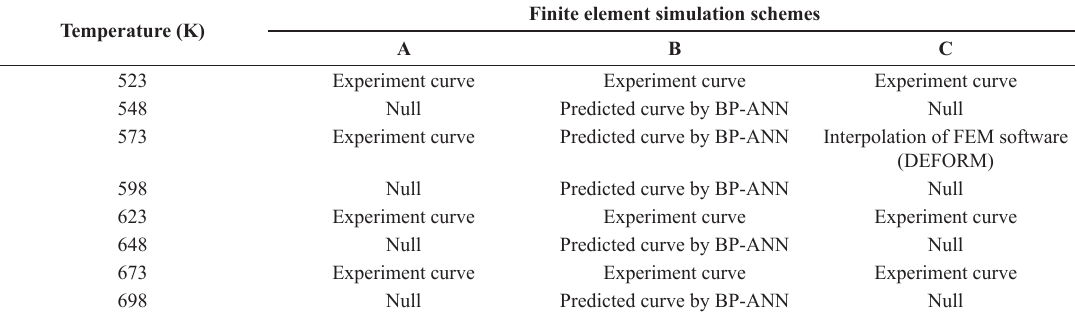
Table 4. These three finite element simulation schemes at the temperatures of 573 K and the strain rate of 1 s –1 . Temperature